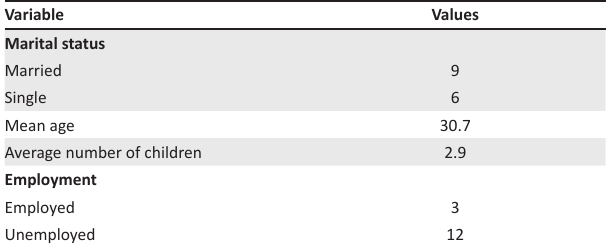
TABLE 1: Participant characteristics.